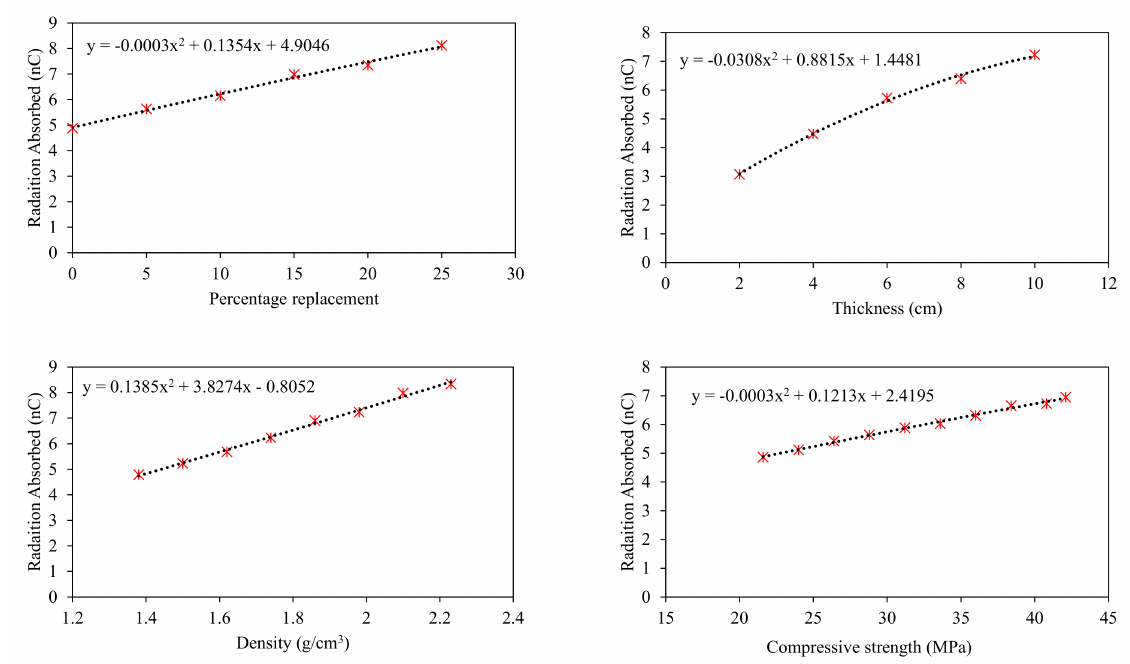
Figure 10. Parametric analysis of ANN model for Type 3